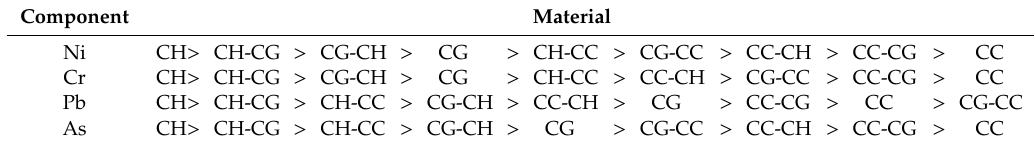
Table 6. Series of materials according to decreasing concentration of individual toxic elements in